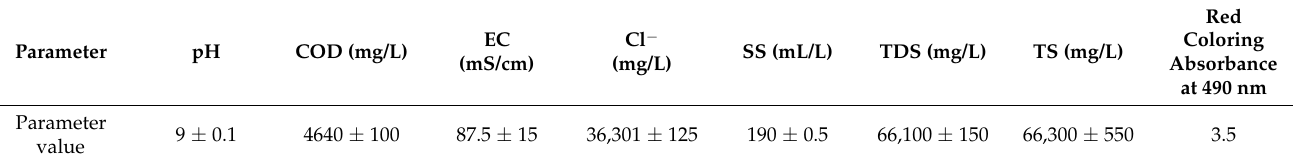
Table 1. Physicochemical characteristics of the industrial